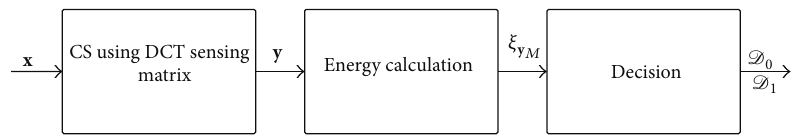
Figure 1: Block diagram of the CMBED algorithm.